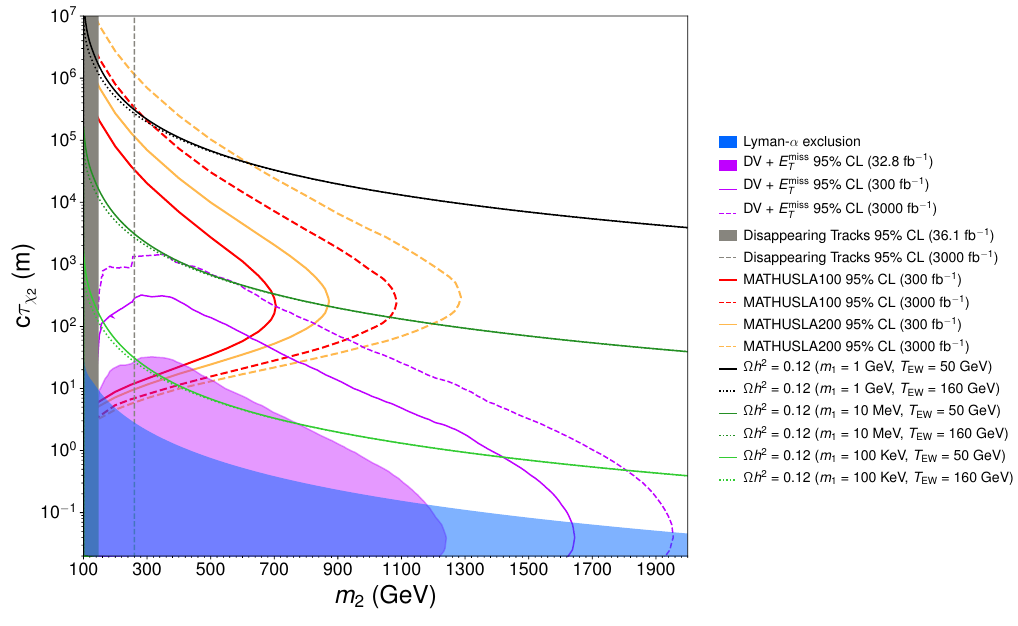
Figure 9 . 13 TeV ATLAS DV + E miss search 95% C.L. exclusion limits with 32 : 8 fb (cid:0) 1 (purple T region) in the ( m 2 , c(cid:28) ) plane, together with its extrapolation to 300 fb (cid:0) 1 (solid purple line) (cid:31) 2 and 3000 fb (cid:0) 1 (dashed purple line). Also shown are the present 95% C.L. exclusion limits from disappearing track searches (grey region) from section 6.2 and the projection for HL-LHC (vertical dashed grey line), as well as the MATHUSLA100 (red) and MATHUSLA200 (orange) projected 95 % C.L. sensitivities (background-free environment assumed, corresponding to N events = 3) for 300 fb (cid:0) 1 (solid line) and 3000 fb (cid:0) 1 (dashed line). Lines yielding the observed DM relic density (cid:10) DM h 2 = 0 : 12 (obtained with micrOMEGAs5.0 ) are shown for m 1 = 1 GeV (black), 10 MeV (dark green), 100 KeV (light green), together with the bounds from Lyman- (cid:11) (blue).